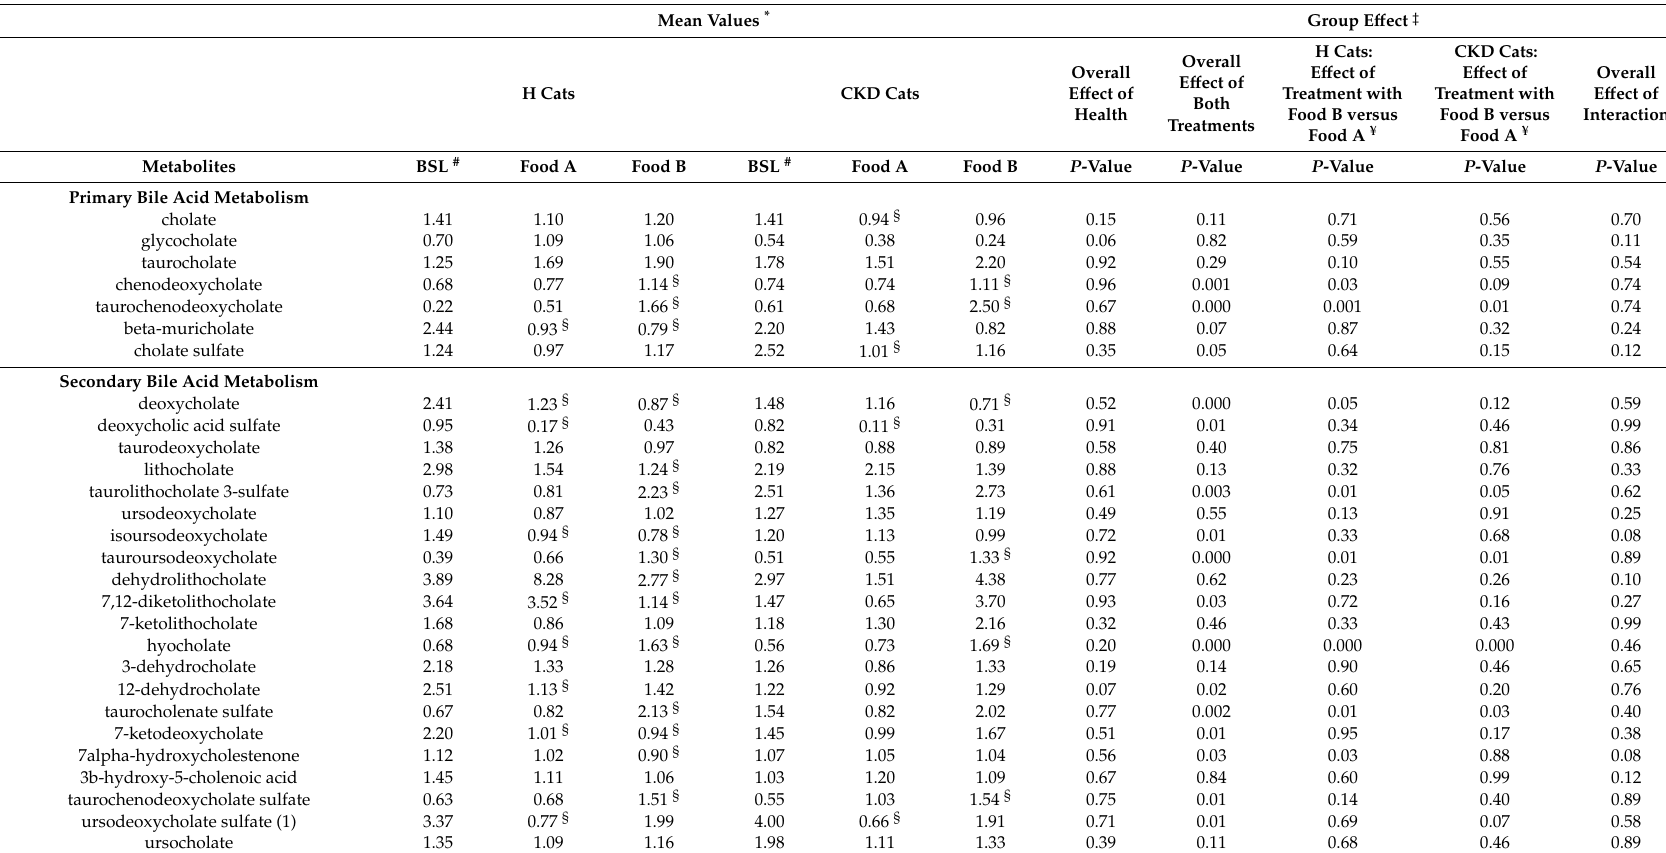
Table 3. Relative fecal metabolite concentrations for primary and secondary bile acid metabolites in healthy cats (H cats) and CKD cats at baseline (after feeding pretrial food 1 for 14 days) and after feeding food A 2 (containing scFOS) or food B 3 (containing apple pomace) as fiber sources for 4 weeks